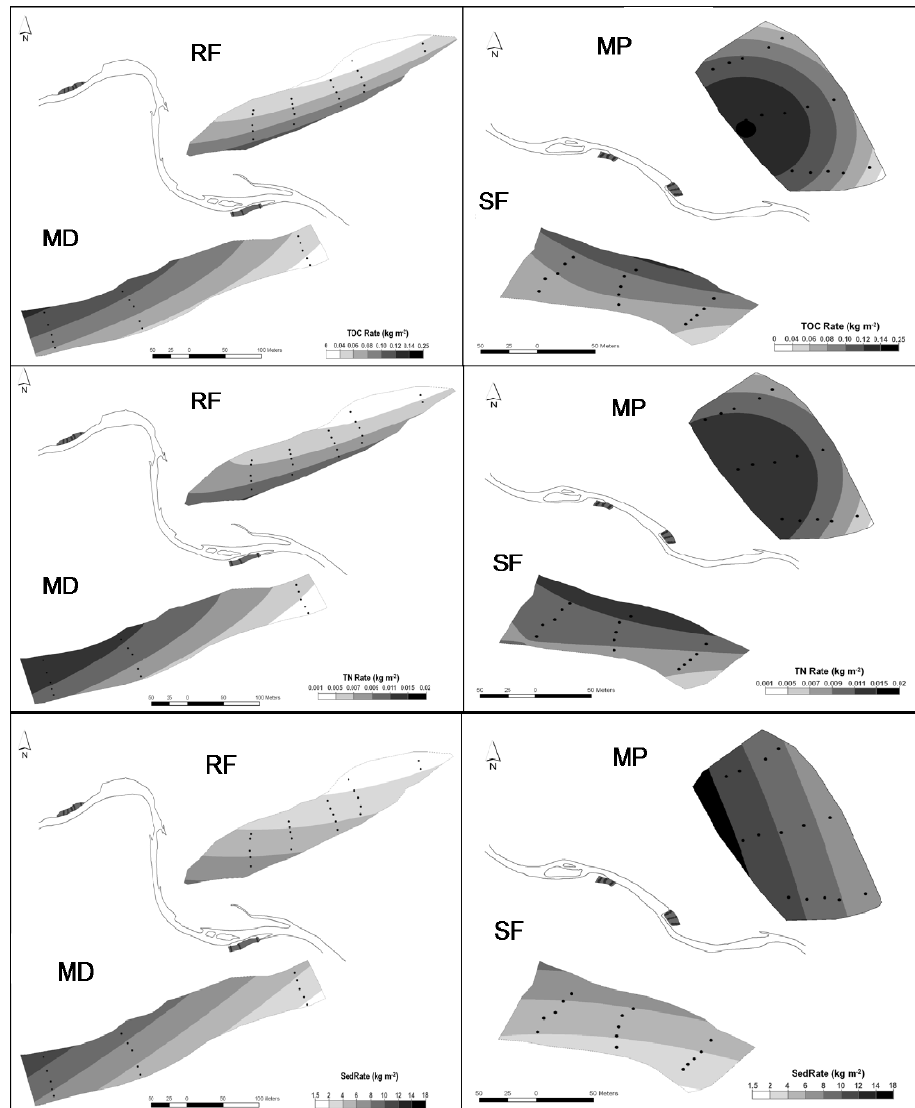
Fig. 5. Prediction maps sediment, TOC and TN deposition after the Generalized linear mixed-effects